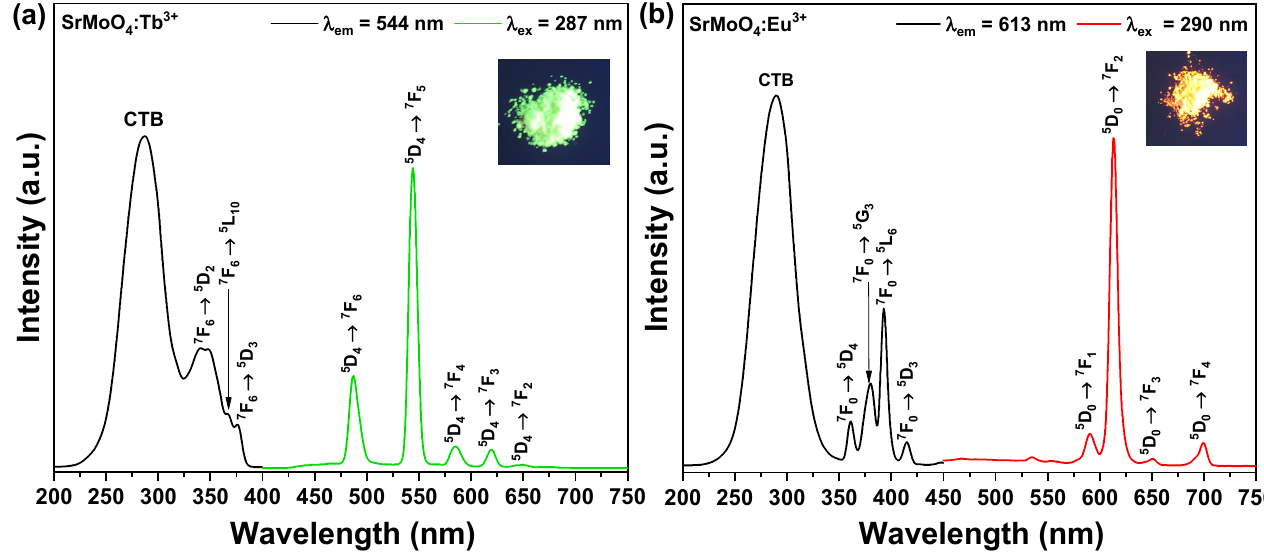
3+ , ( b ) SrMoO 3+ 4 :Tb 4 :Eu